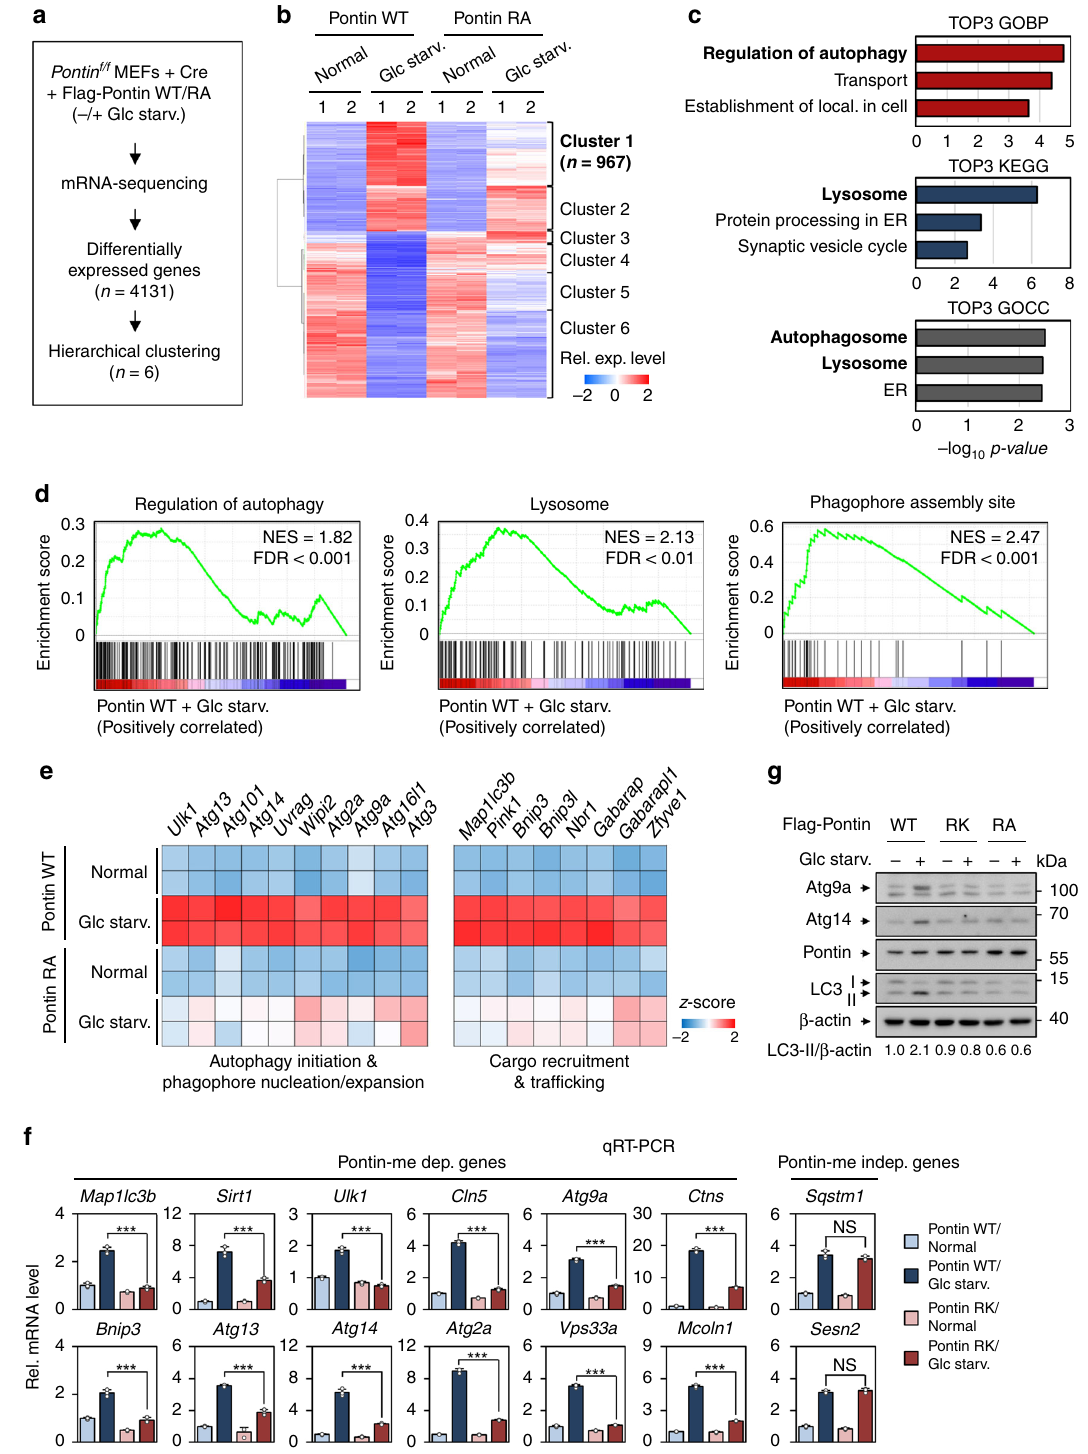
Fig. 4 RNA-sequencing analysis reveals that methylated Pontin-dependent genes are enriched for autophagy and lysosomal genes. a Flow chart showing the strategy of RNA-sequencing analysis. b Hierarchical clustering results applied to 4131 differentially expressed genes (DEGs). c Gene ontology enrichment and KEGG pathways enrichment analyses for the genes in Cluster 1 using DAVID software. d Representative gene set enrichment analysis (GSEA) results (ranking genes by Pearson correlation with the phenotypic labels based on the Cluster 1). e Pontin methylation-dependent genes sorted by autophagy steps. Heatmaps representing expression changes of genes. f Quantitative RT-PCR analysis of methylated Pontin-dependent autophagy and lysosomal genes. Bars, mean ± s.e.m.; n = 3; *** p < 0.001, NS non-signi fi cant. Statistics by two-tailed t -test. g Immunoblot analysis of Pontin methylation- dependent genes in cell lysates of Pontin WT, RK, or RA MEFs upon glucose starvation. Source data are provided as a Source Data fi